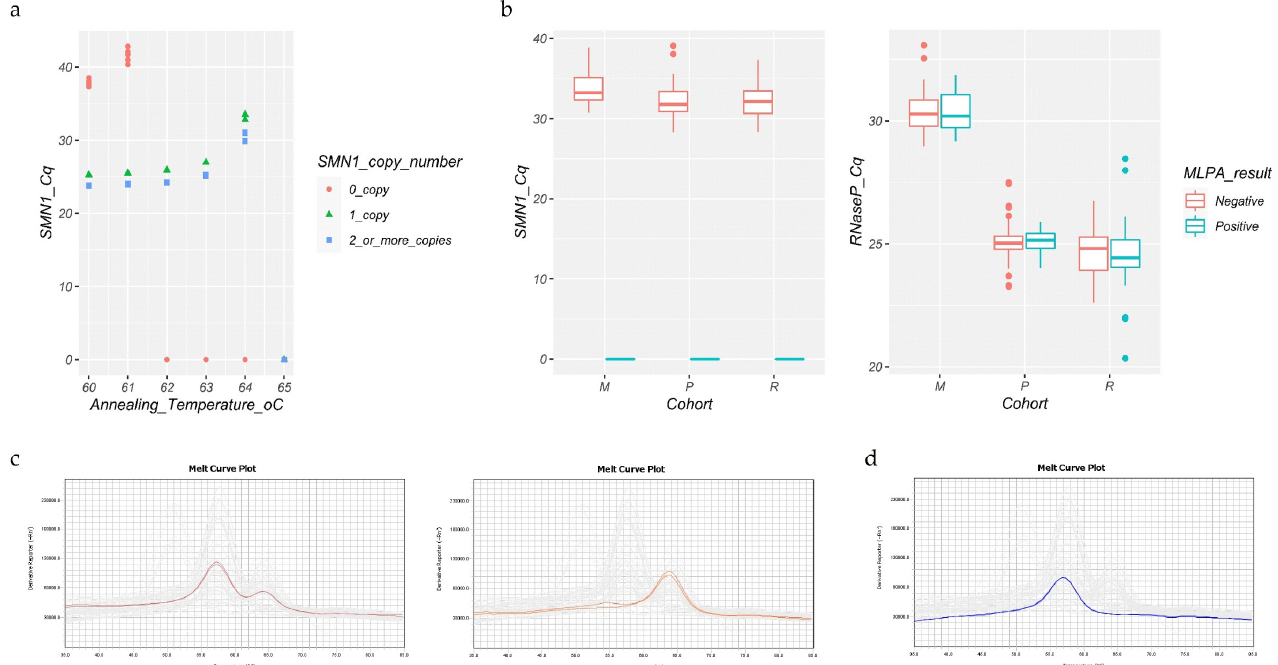
Figure 1. ( a ) Temperature gradient. The specificity for SMN1 over SMN2 is observed at 62 ◦ C, 63 ◦ C, and 64 ◦ C. The highest specificity was chosen for the assay. The SMN1 copy number refers to the MLPA genotypes. ( b ) Box plots of the Cq values obtained in the real-time PCR test. The box colors indicate the result obtained through MLPA. The data include inconclusive samples. Significant differences were observed for the medians of the SMN1 Cq values between the mixed compared to the retrospective and prospective cohorts ( p -values < 0.0005). The RNase P Cq medians were different among all the comparisons ( p -values < 0.0005). M, mixed cohort; P, prospective cohort; R, retrospective cohort. ( c , d ) The melt curve assay. Representative plot of two negative samples showing SMN1 peaks in both images and a SMN2 peak in the right one ( c ); representative plot of a positive sample result showing just the SMN2 peak ( d